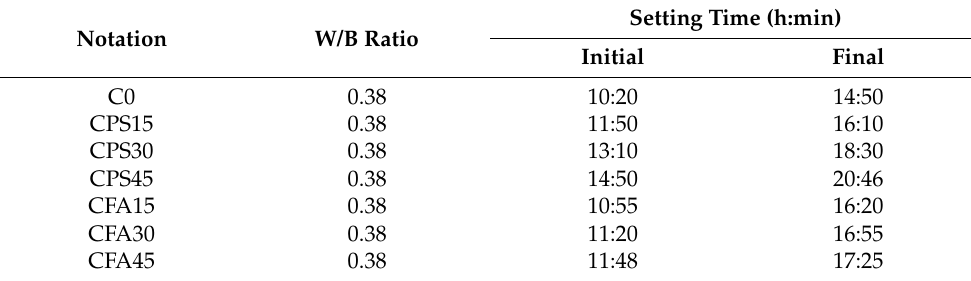
Table 3. Setting time of hydraulic concretes added with FGPS and fly ash.